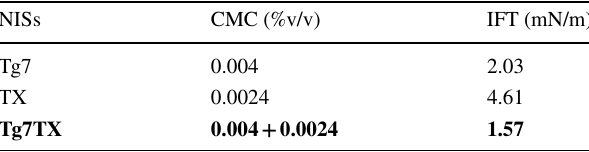
NIS Non Ionic Surfactants, CMC Critical Micelle Concentration, IFT